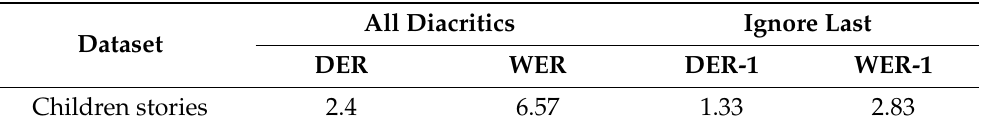
Table 6. Diacritization results of our DBN model on the children’s stories dataset.